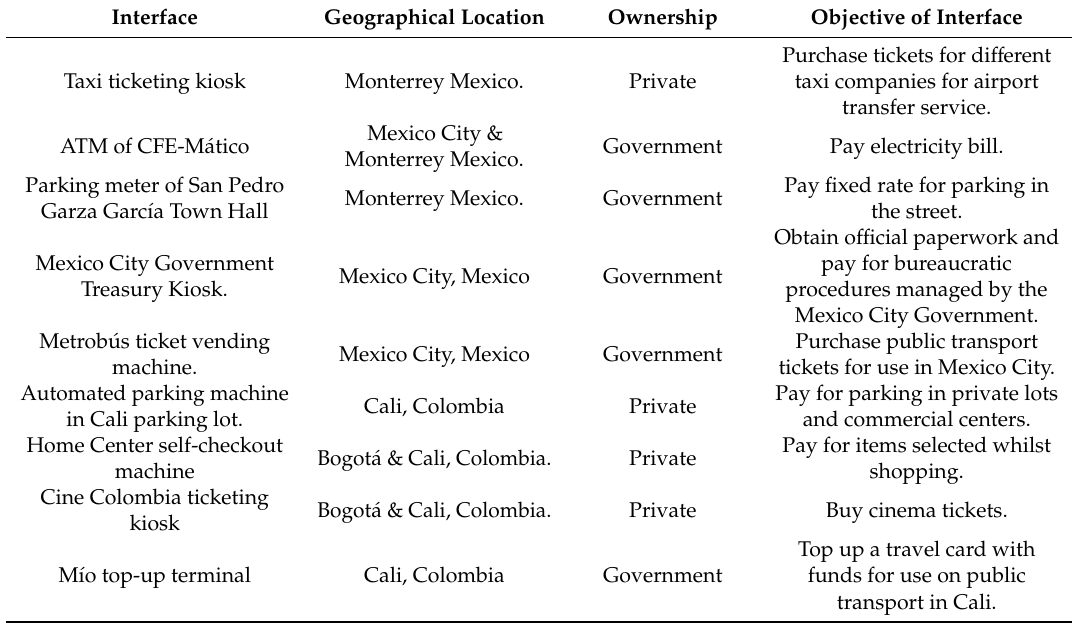
Table 3. List of Urban Digital Interfaces